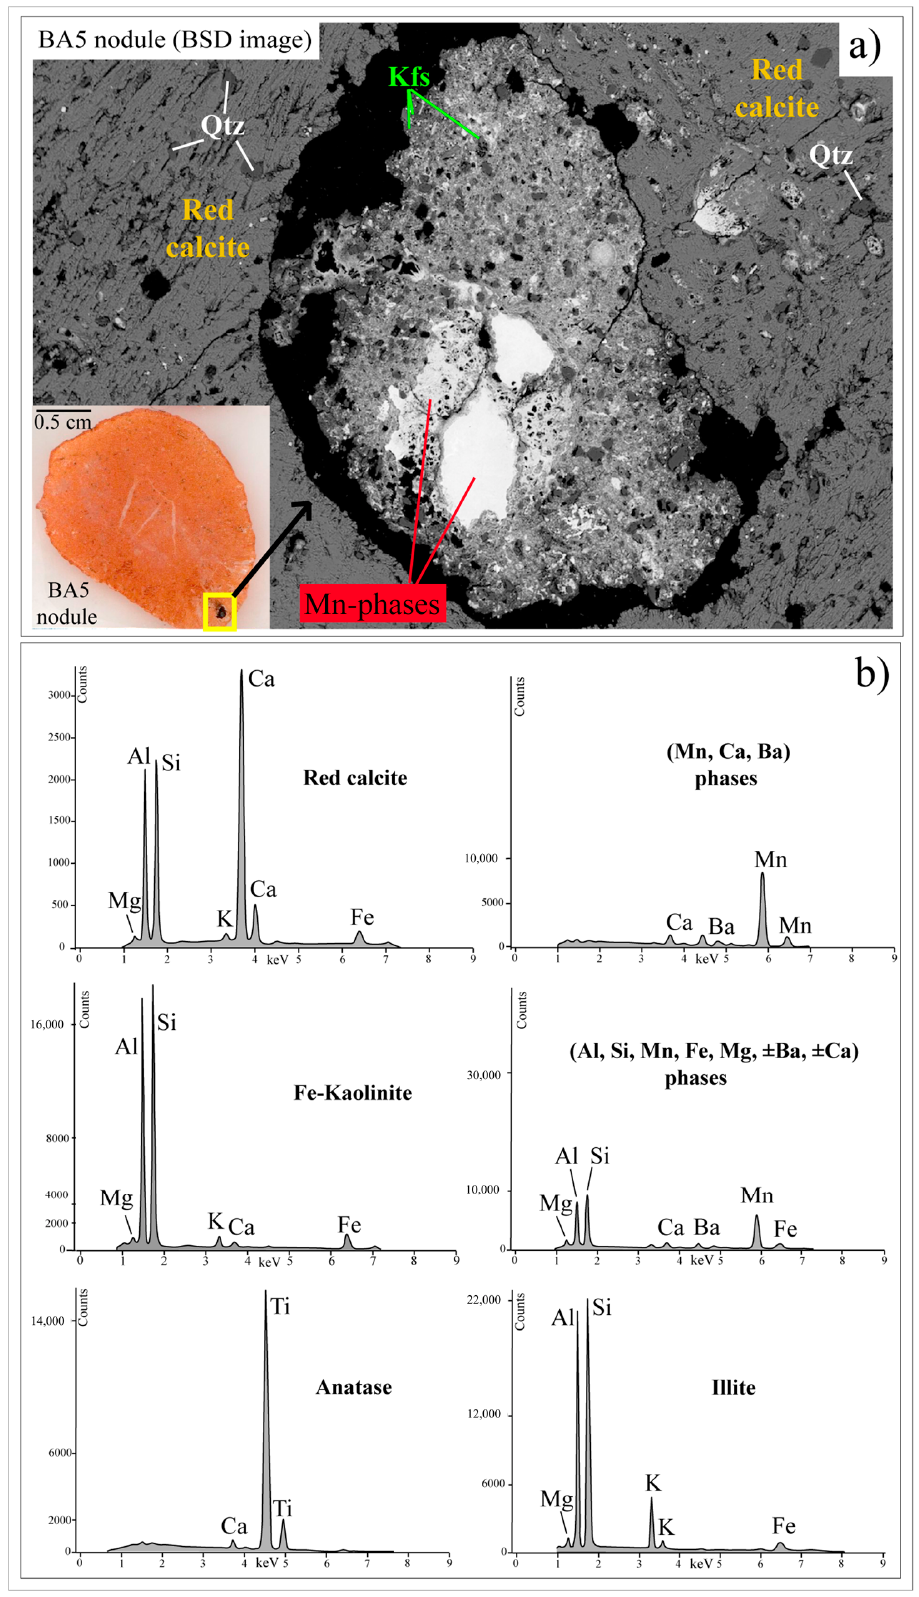
Figure 6. ( a ) Red calcite nodule BA5 and the detail of a lithic fragment incorporated in its peripheral portion (BSD-SEM image); ( b ) SEM-ED spectra relative to the several phases revealed in the lithic fragment and nodule.